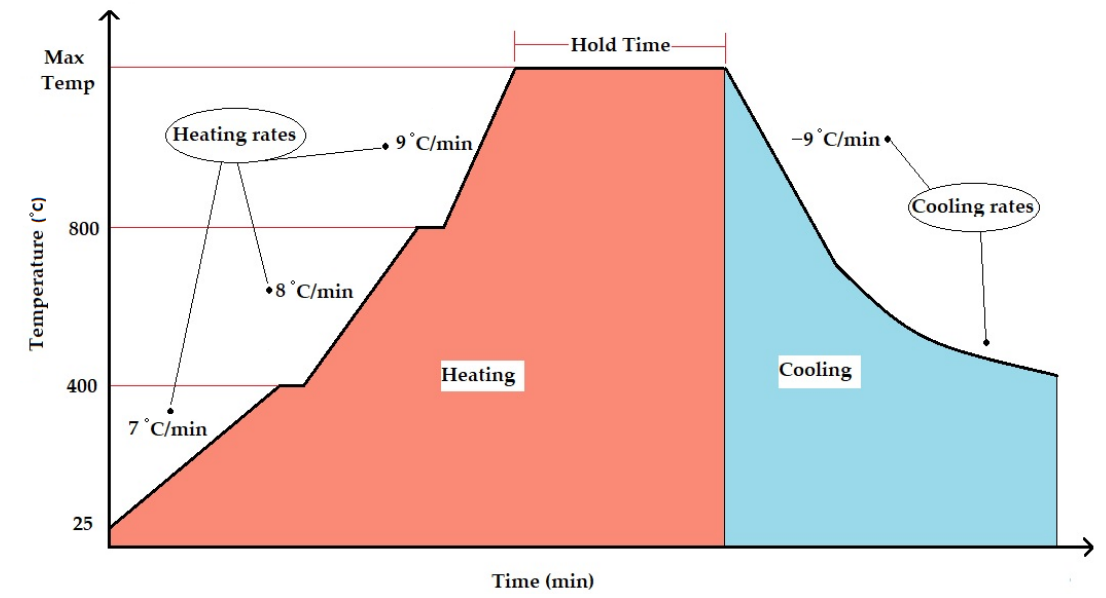
Figure 5. The general profile of the sintering cycle used in this study.